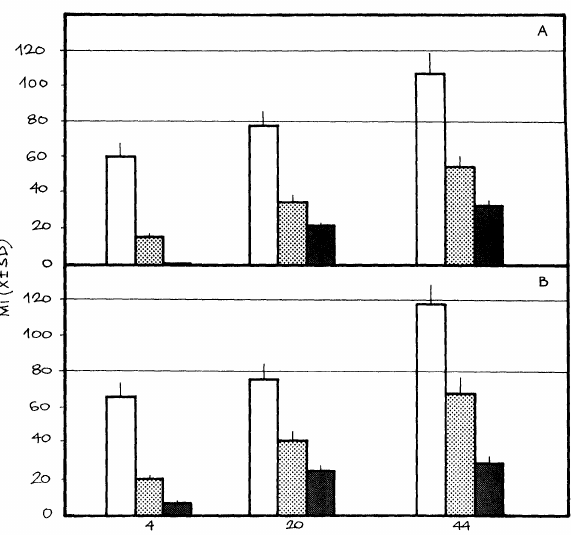
FIG. 2. The effect of macrophage preincubation with thrombin on their random migration in M 199 either (A) not or (B) supple- mented with 10% serum. The 6-day macrophages were pre- incubated 30 min with thrombin (I-I U/ml, 5 U/ml, 10 U/ml, in M 199). n 5-7 per group. For the significance levels see Material and Methods.